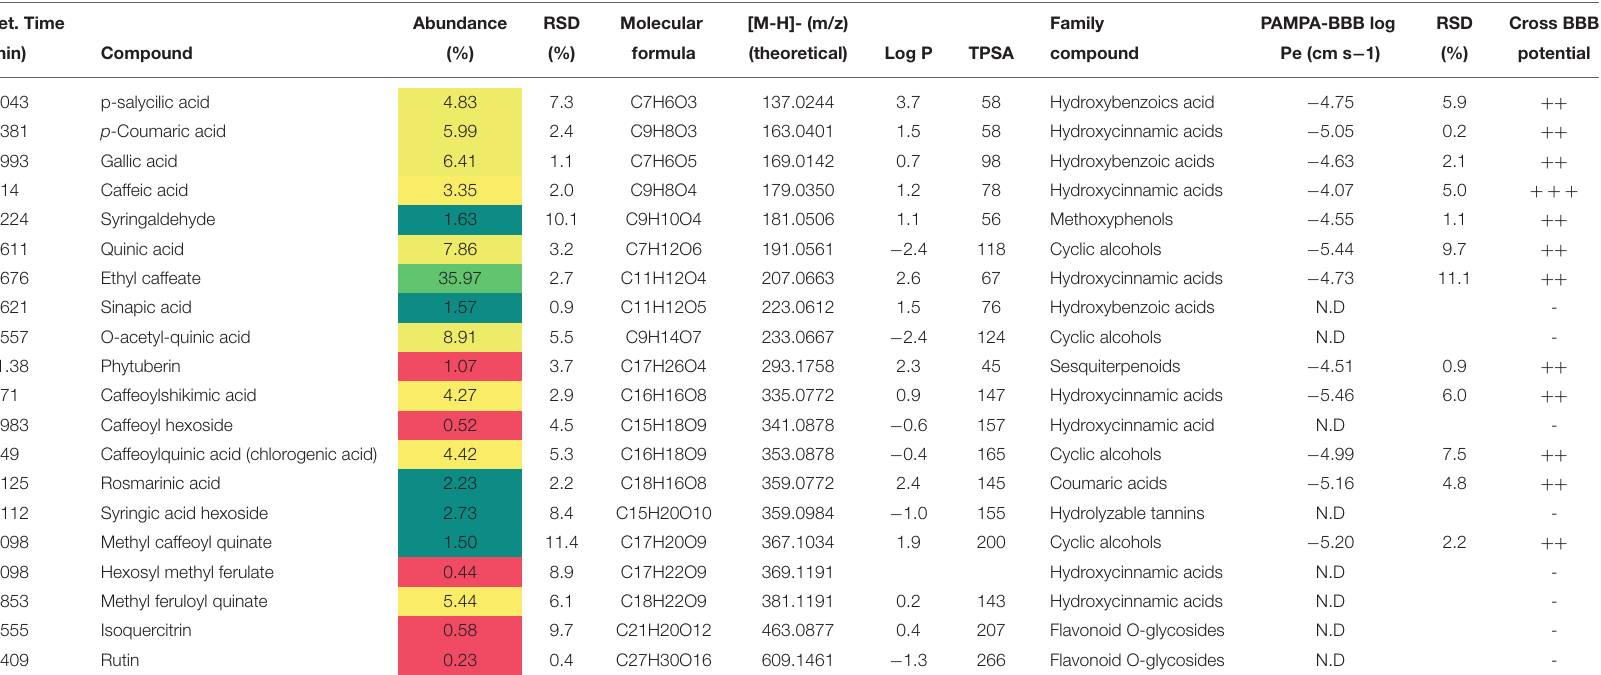
TABLE 5 | Phytochemical profile, abundance (%), and BBB permeability of T33 (Cyphomandra betacea, tamarillo PLE extract). Ret.